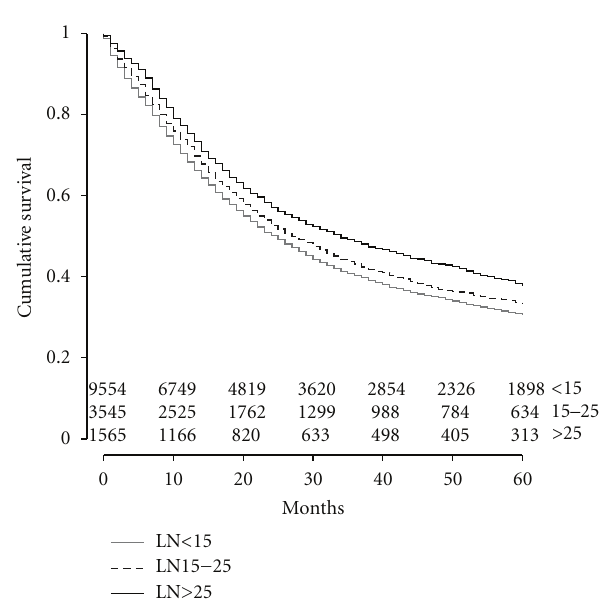
Figure 1: Kaplan Meier curve of overall survival by lymph node resection. Lymph node (LN).